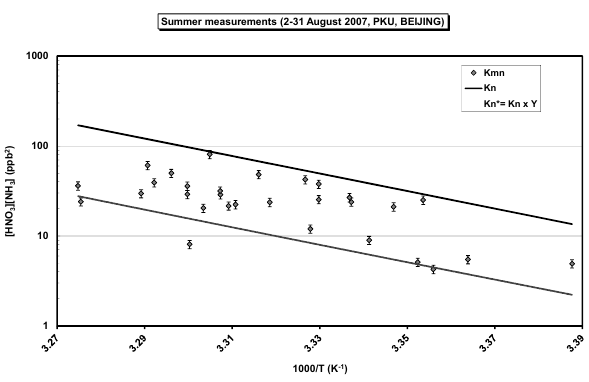
Fig. 6. Thermodynamically predicted equilibrium dissociation con- stant K n (black solid line) for pure NH 4 NO 3 , K n * (grey solid line) for NH + /NO − /SO 2 − mixtures, and measured concentration prod- 4 3 4 uct K mn =[HNO 3 ][NH 3 ] as a function of temperature for summer period at Beijing. The K n , K n * and K mn constants have been de- termined by data collected on a 24-h